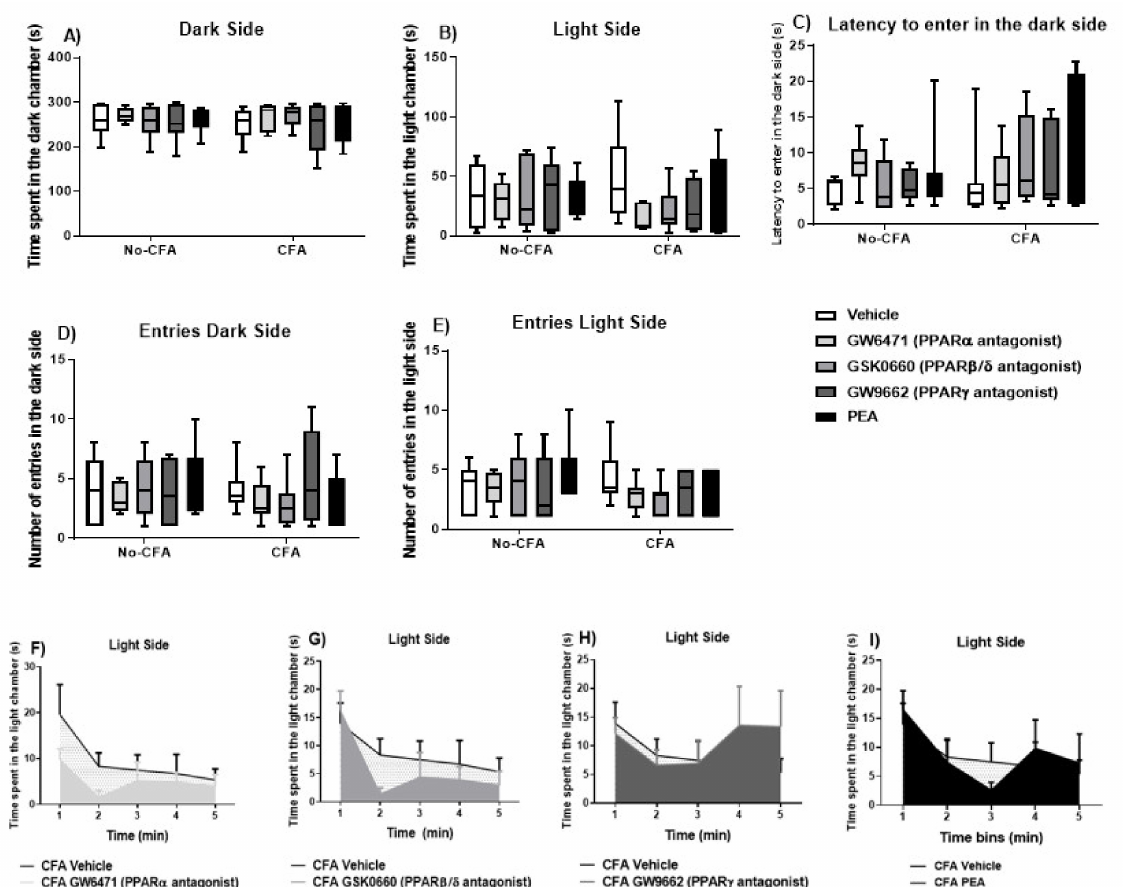
Figure 6. Effects of systemic administration of vehicle, selective PPAR α (GW6471), PPAR β / δ (GSK0660) and PPAR γ (GW9662) antagonists, and PEA on anxiety-related behaviours in the LDB test in CFA-injected (CFA) and control (No-CFA) rats. Data are expressed as median with interquartile range and min/max ( A – E ) or means ± SEM ( F – I ) ( n = 7–8 rats per group). In the CFA-injected groups, the area under the curve (AUC) analysis indicated a trend for a decrease in time spent in the light side in GW6471-treated ( p = 0.075; F) and GSK0660-treated ( p = 0.07; G) rats compared to vehicle counterparts. The AUC analysis was done on all groups together but are presented separately for presentation/readability purposes. Data are presented as means ± S.E.M. ( n = 7–8 rats per